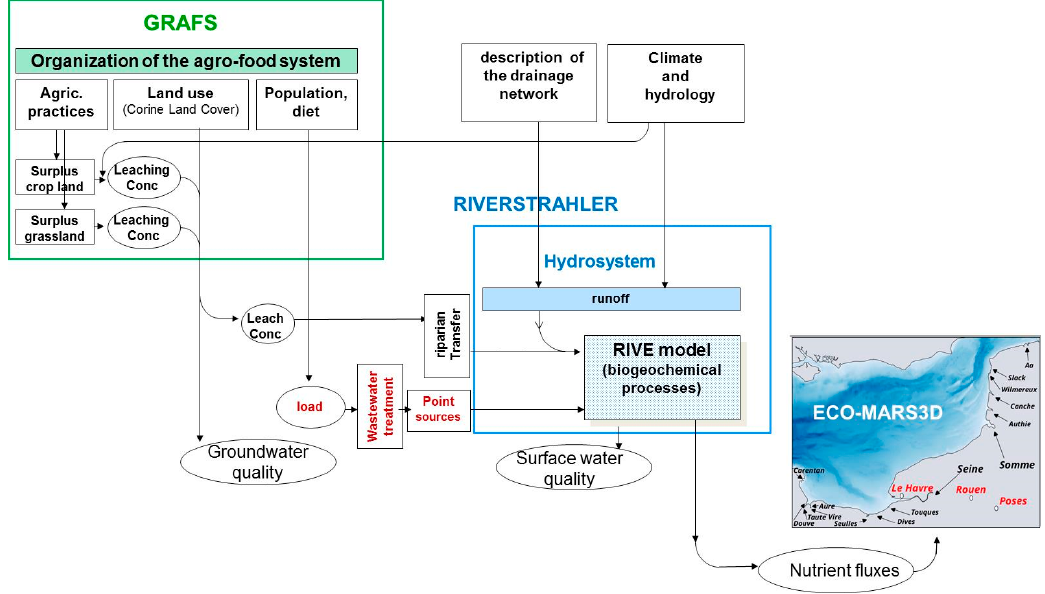
Figure2. RepresentationoftheprinciplesoftheGRAFS / RIVERSTRAHLER / Figure 2. Representation of the principles of the GRAFS/RIVERSTRAHLER/ECO-MARS3D model chain.